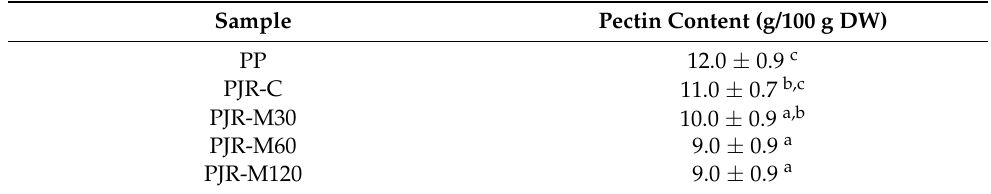
Table 2. Pectin content of untreated persimmon pulp (PP) and persimmon juice residues (PJR) obtained from juice production process without (PJR-C) or with pulp treatment at different microwave heating conditions (PJR-M30, PJR-M60, and